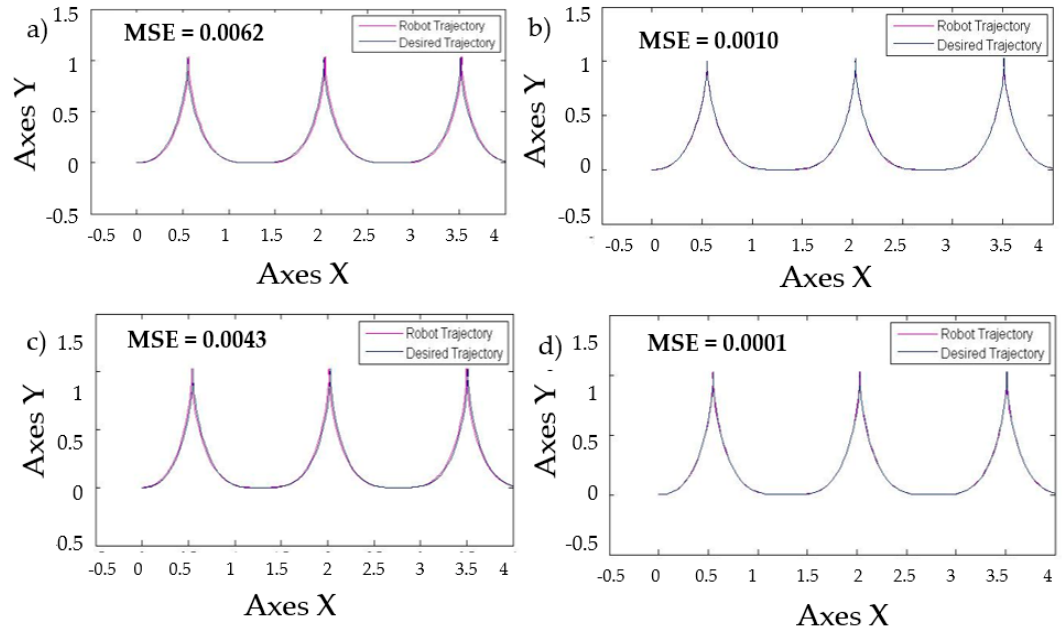
Figure 20. Behavior of trajectory for each method with pulse generator perturbations with value of 1. ( a ) Traditional BCO; ( b ) Fuzzy BCO with Type-1 FLS; ( c ) Fuzzy BCO with IT2FLS; and ( d ) Fuzzy BCO with GT2FLS.